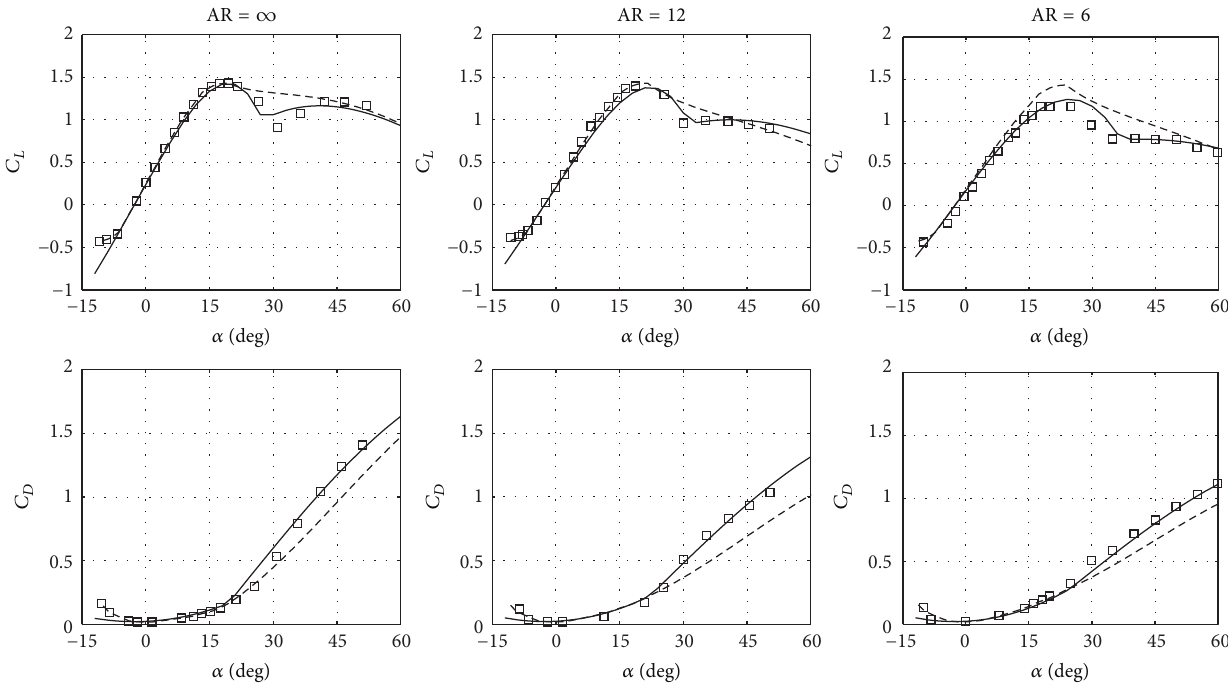
Figure 5: Coefficients of poststall lift and poststall drag as a function of angle of attack measured by Ostowari and Naik [5] (square marker) and predicted by AERODAS (solid line) and Viterna (dashed line) for NACA 4415 blades having aspect ratios (AR) of infinity, 12, and 6 at Re = 2.5 × 10 5